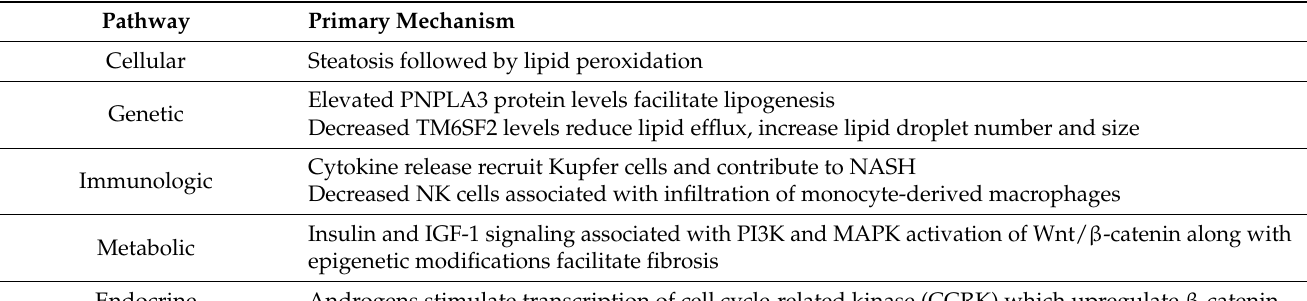
Table 1. Pathways contributing to the development of hepatocellular carcinoma (HCC) from non-alcoholic steatohepatitis